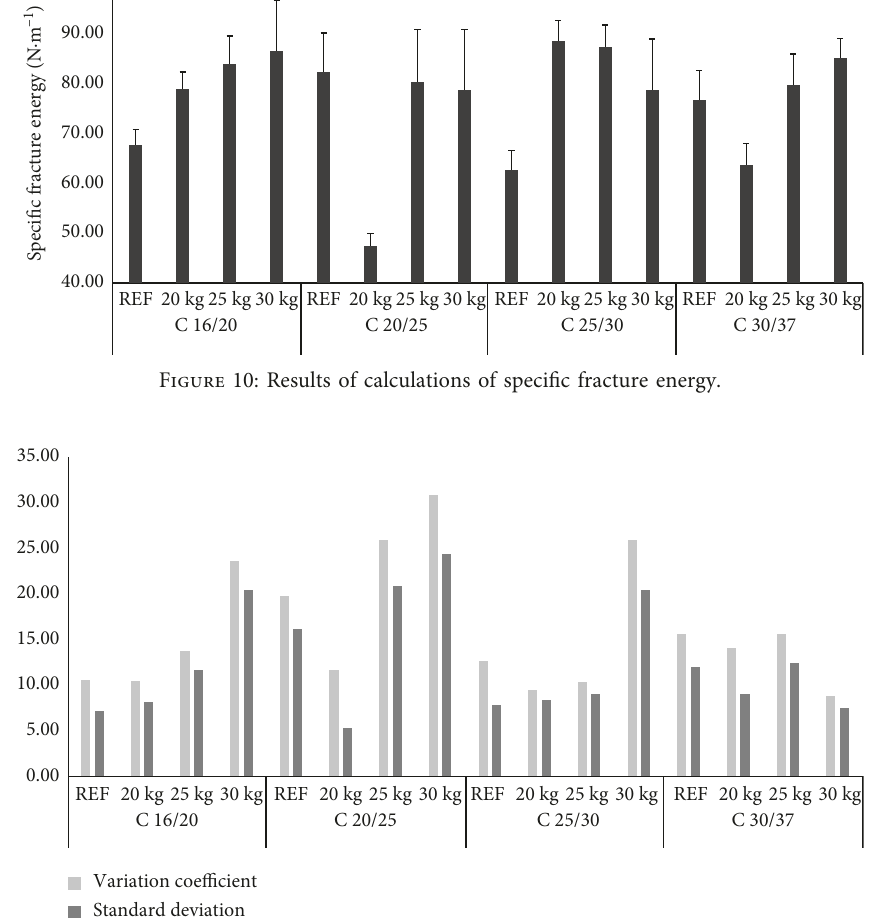
Figure 11: Representation of the coefficient of variation and standard deviation in the calculations of specific fracture energy from the working diagrams of the performed